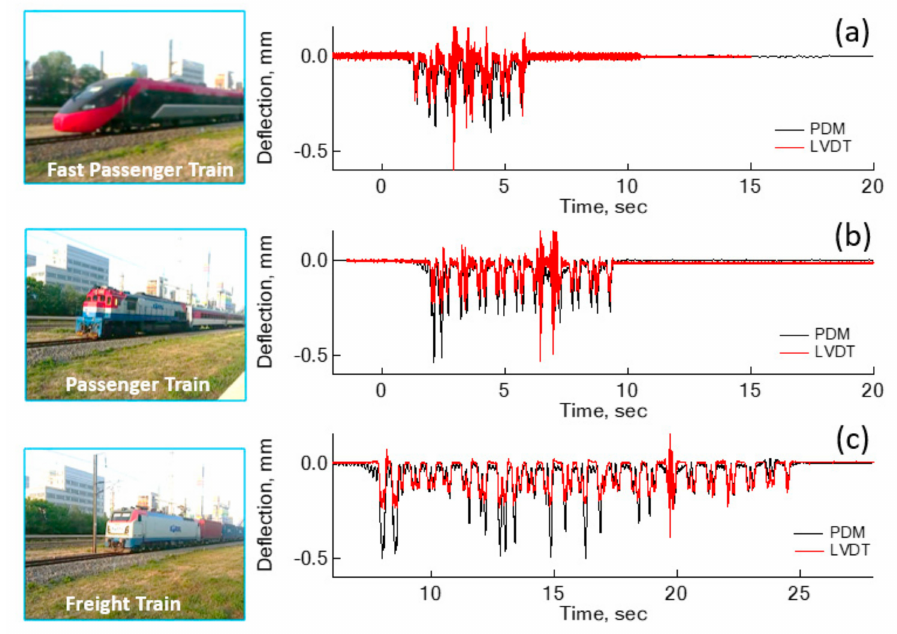
Figure 6. Further examples of deflections evaluated by the PDM, compared with linear variable differential transformer (LVDT) deflections: ( a ) ITX-Saemaeul Train, ( b ) Moogunghwa Train, and ( c ) Freight